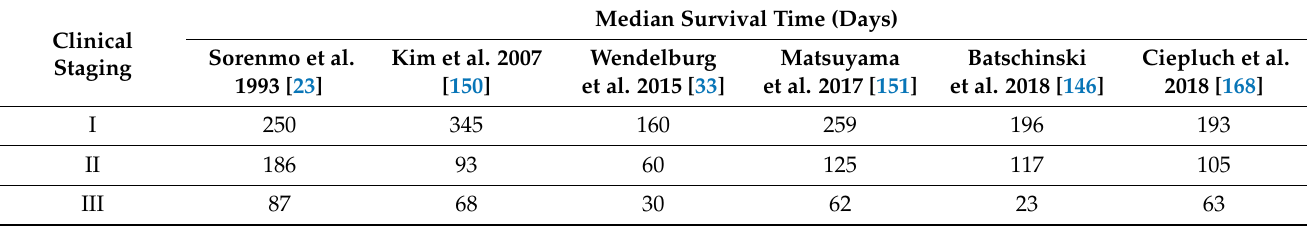
Table 6. Prognosis and mean survival time of dogs affected by splenic HSA, according to clinical